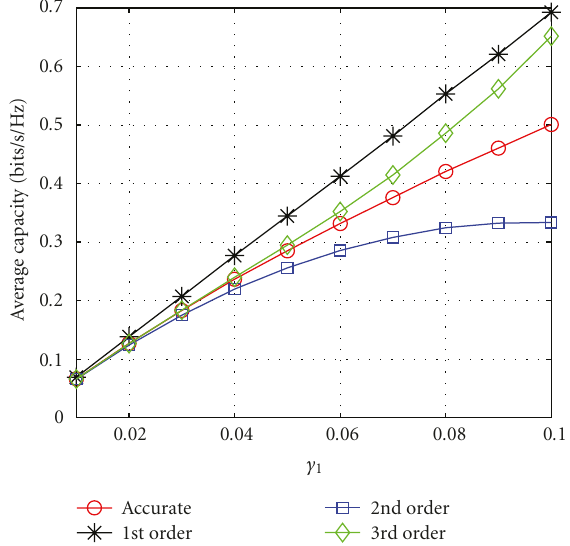
Figure 5: Eigenvalue moments versus various α in the high β region.